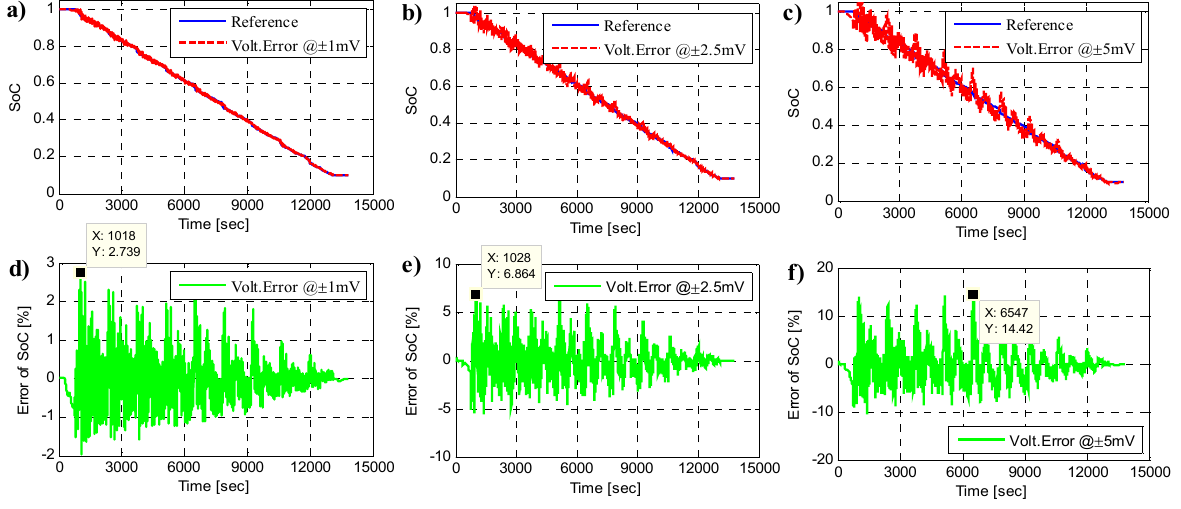
Figure 11. SoC estimation results at the voltage sensor precisions of ( a ) ±1 mV, ( b ) ±2.5 mV, ( c ) ±5 mV; and the SoC error at the voltage sensor precisions of ( d ) ±1 mV, ( e ) ±2.5 mV, ( f ) ±5